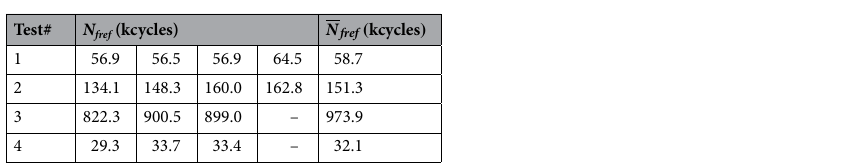
Table 2. Lifetime results of reference tests.